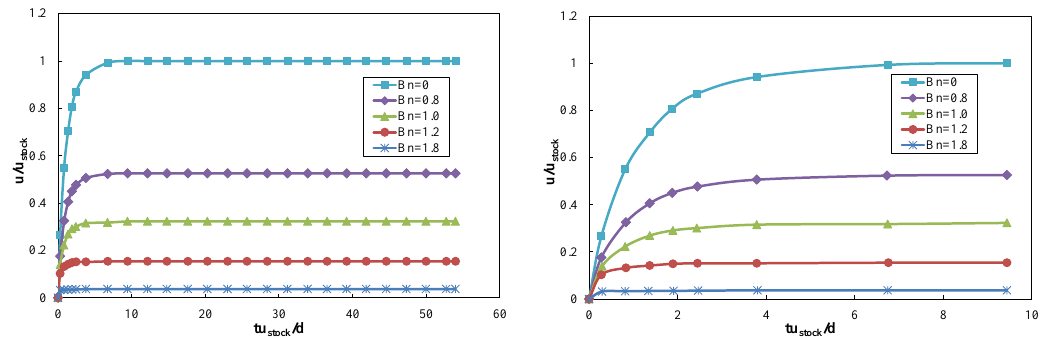
Figure 4. Falling velocities of particle in Bingham fluid changing with time (left: total process; right: in the beginning).